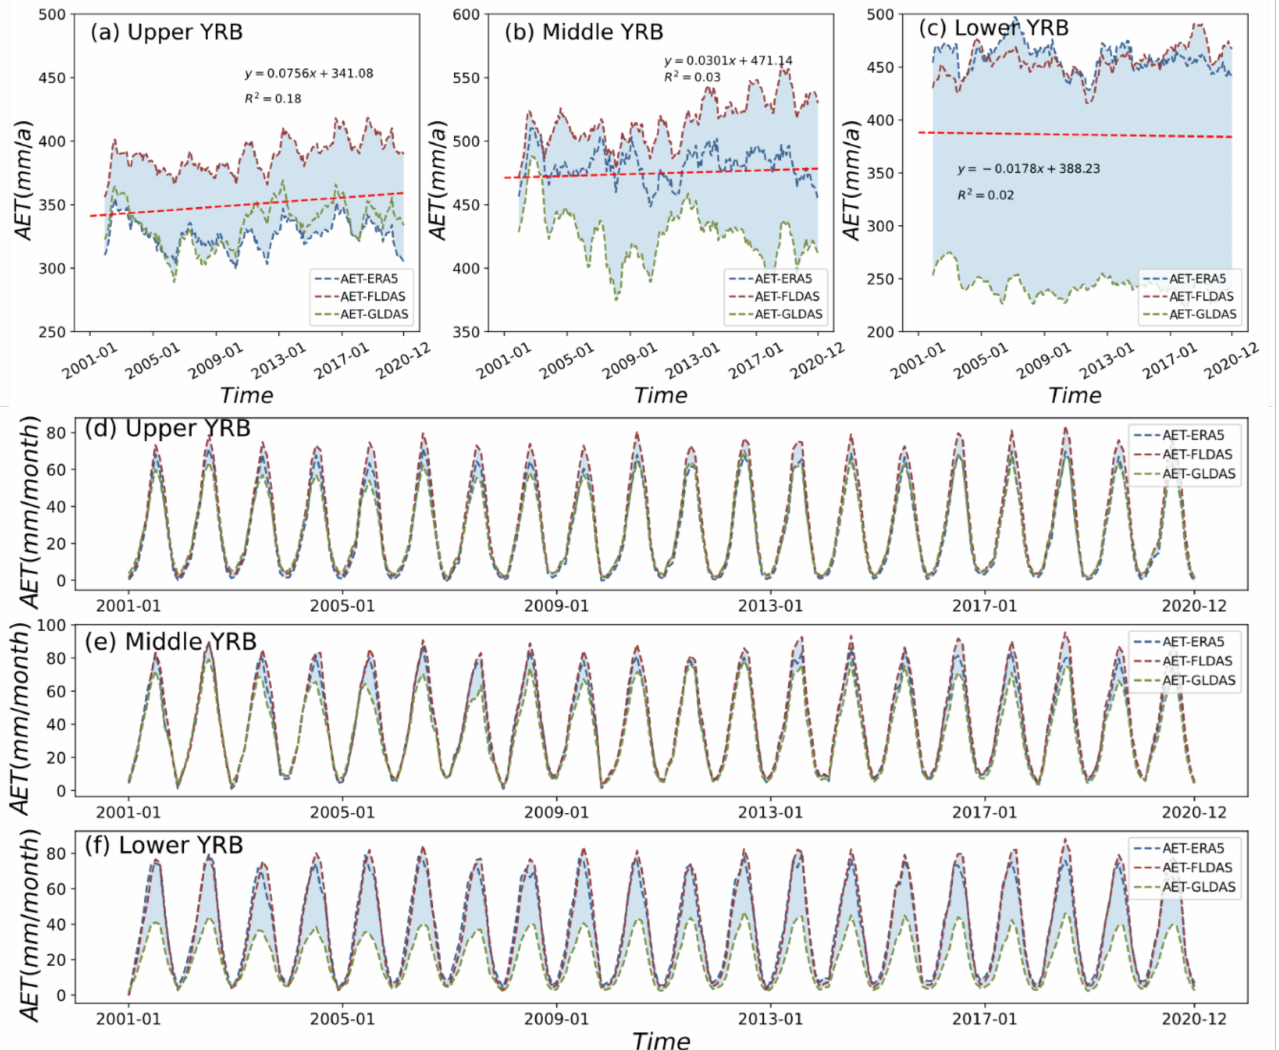
Figure 5. The annual ( a – c ) and monthly ( d – f ) variations in the mean actual ET estimated by MEP method with three different data sources (ERA5, GLDAS, and FLDAS) in sub-basins of the YRB; Upper YRB: ( a , d ); Middle YRB: ( b , e ); Lower YRB: ( c , f